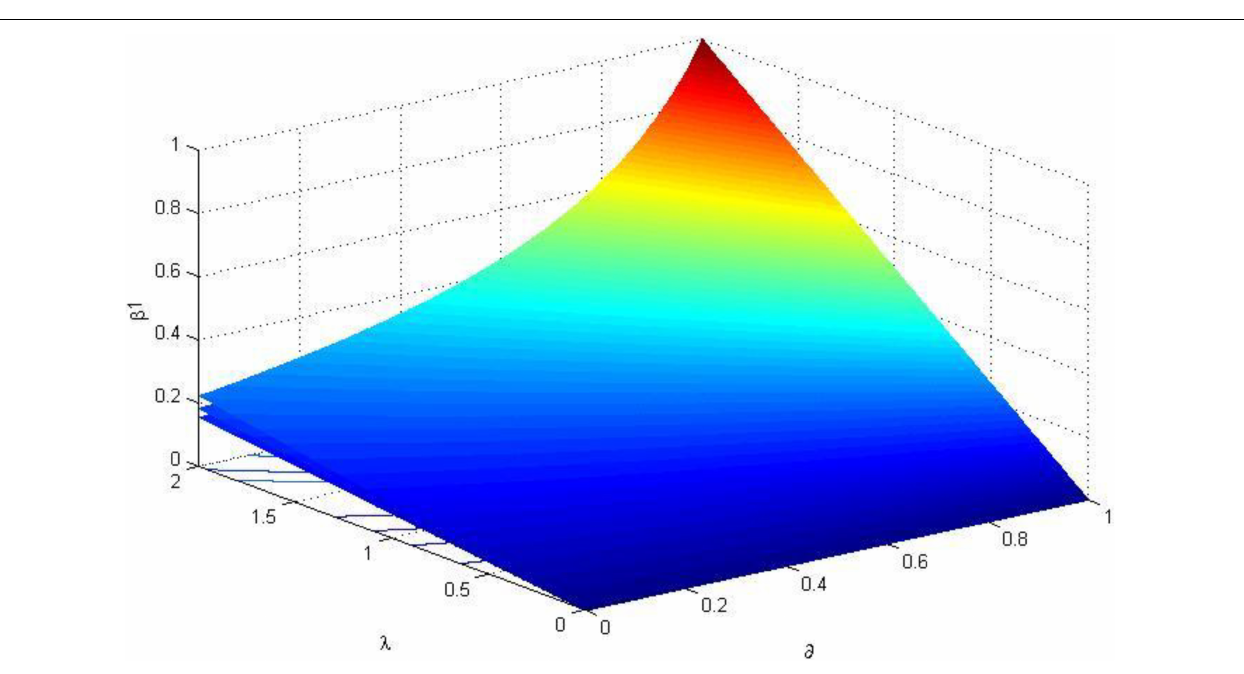
Frontiers in Psychology |